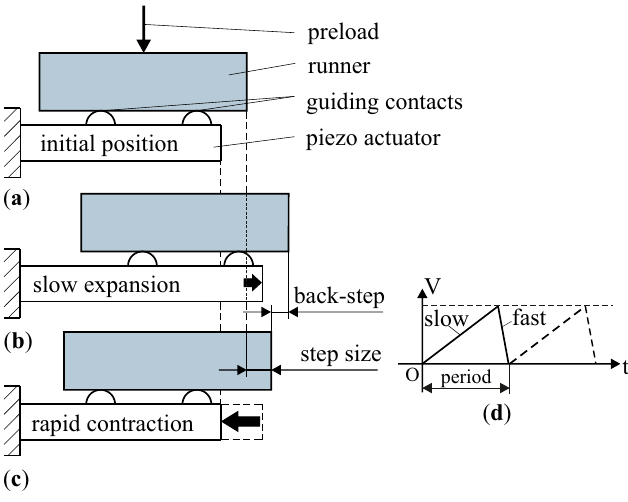
Figure 1. Components and working principle of piezo-actuated stick–slip micro-drives: ( a ) initial position; ( b ) stick-phase; ( c ) slip-phase; ( d ) saw-tooth-like driving voltage applied on the